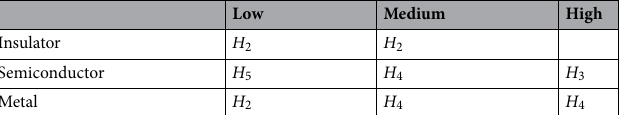
Table 7. The Classic Calculator considering bandgap and density simultaneously (CLA 3 ). Materials are classified by bandgap ( (cid:31) E ) as insulators ( � E > 2 eV), semiconductors ( � E < 2 eV) and metals ( (cid:31) E = 0 ); and